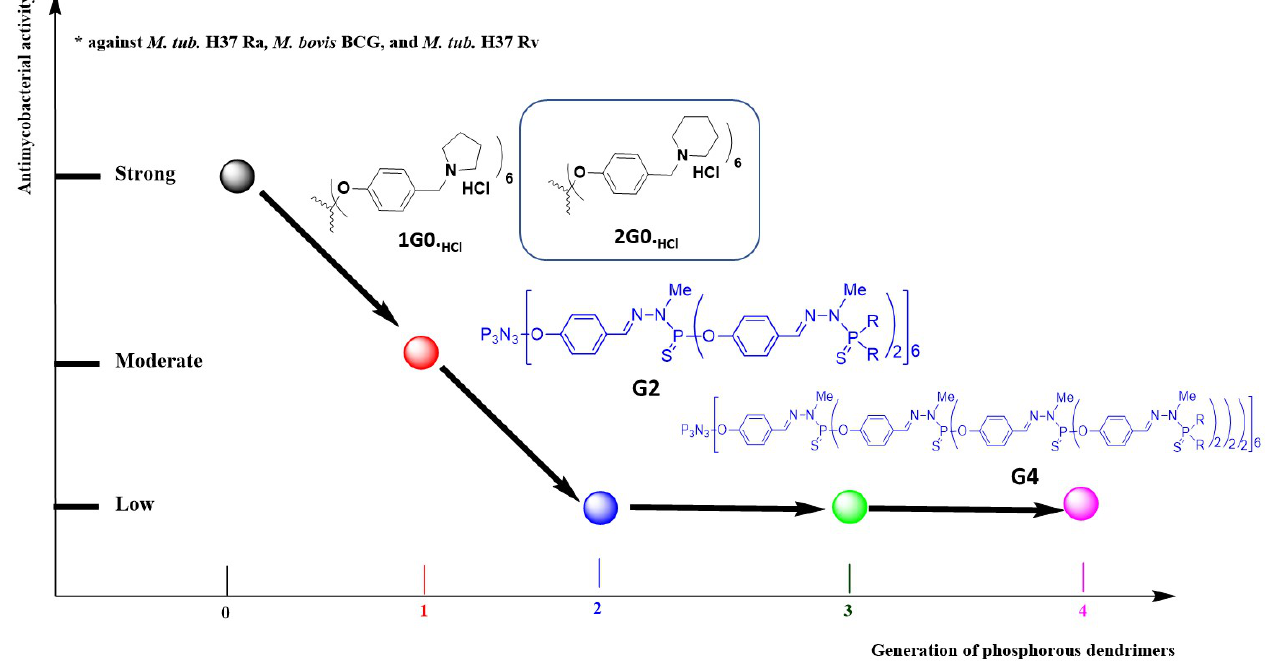
Figure 10. SARs between the generation of dendrimers (0–4) and their respective antimycobacterial activities.